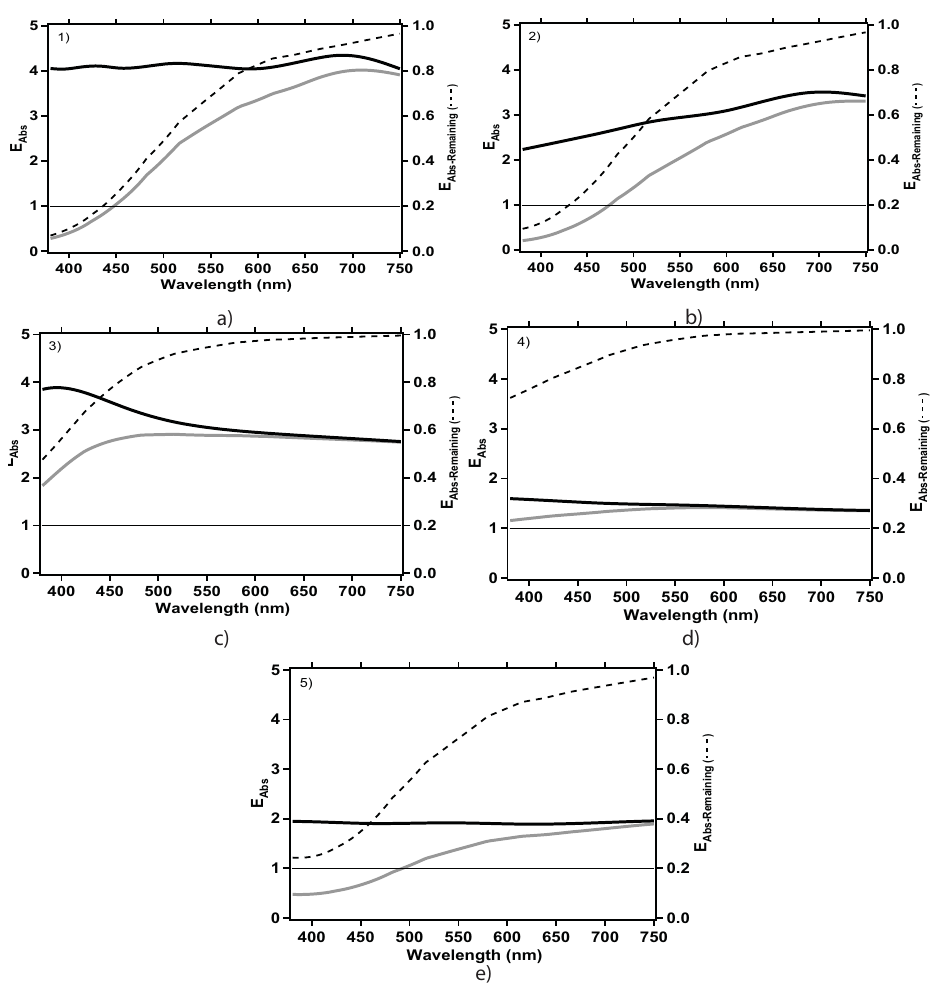
Fig. 5. Calculated E Abs for BC cores having C Clear shells ( E Abs − CL , solid black) and C Brown shells ( E Abs − BR − X , solid gray). Each numbered panel corresponds to the central conditions of the numbered regimes in Bond et al. (2006). The dashed line shows E Abs − Remaining